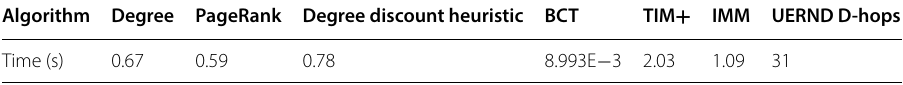
50 under the LT model =